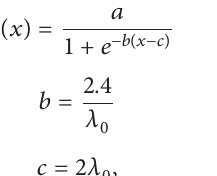
Figure 2: Geometry of the proposed antenna. Antenna dimensions (unit: mm): 𝐿 = 12.75 (4𝜆 0 ) , 𝑤 𝑖 = 1.63 , 𝑤 0 = 2.24 (0.7𝜆 0 ), 𝑤 𝑔 = = 𝑤 = 0.13 , and 𝑙 = 0.48 . 0.13 , 𝑑 = 0.61 , 𝑤 𝑐 𝑑 𝑐